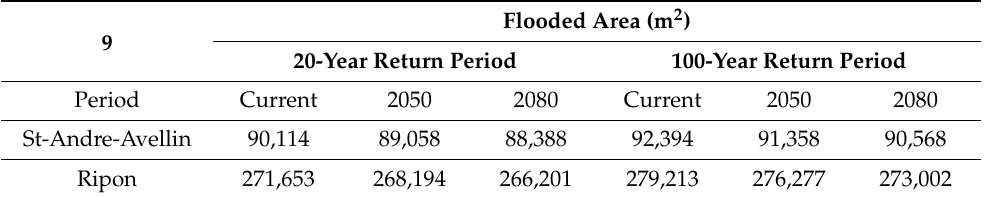
Table 2. Comparison of flood inundation areas for 20- and 100-return periods for current (baseline), 2050-, and 2080-time horizons under RCP 8.5 for the two municipalities: Ripon and